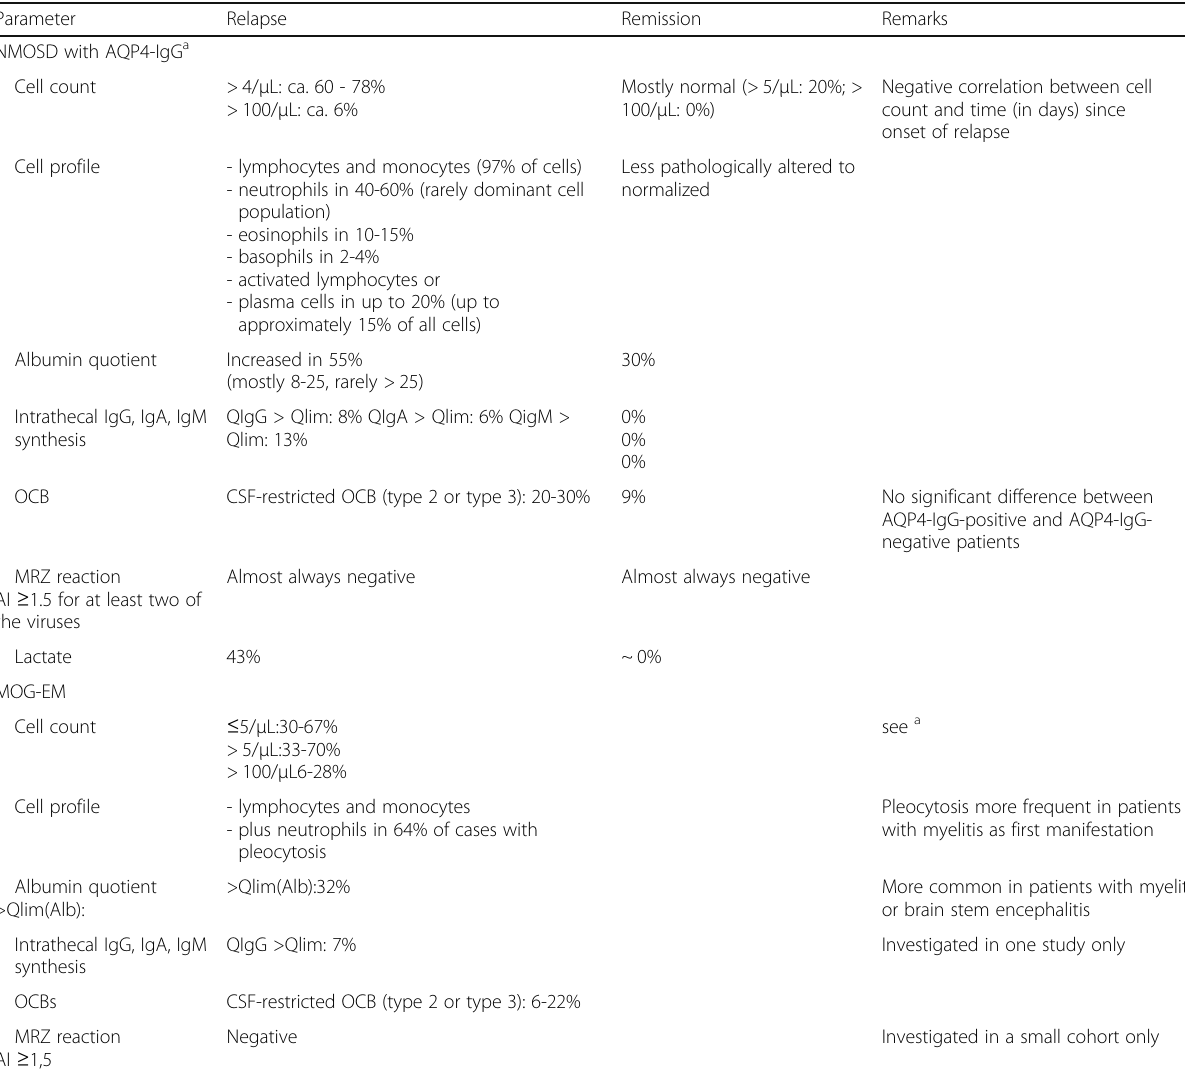
Table 16 Overview of relevant CSF parameters and frequency of abnormalities during relapse and in remission